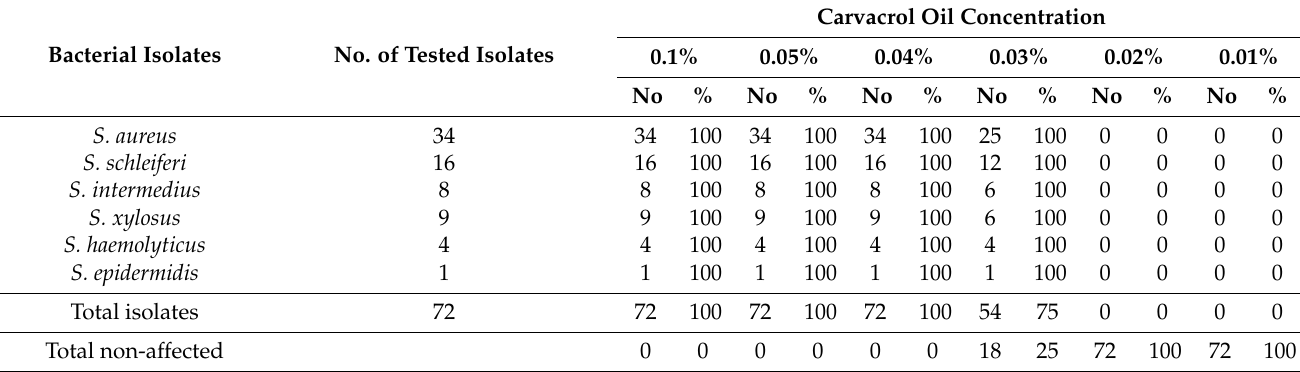
Table 3. Antibacterial effect of carvacrol oil on MDR Staphylococcus isolates.